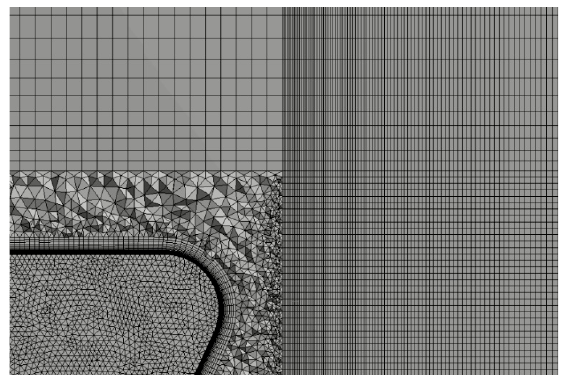
Figure 3. Hybrid mesh in weather vane tail area.